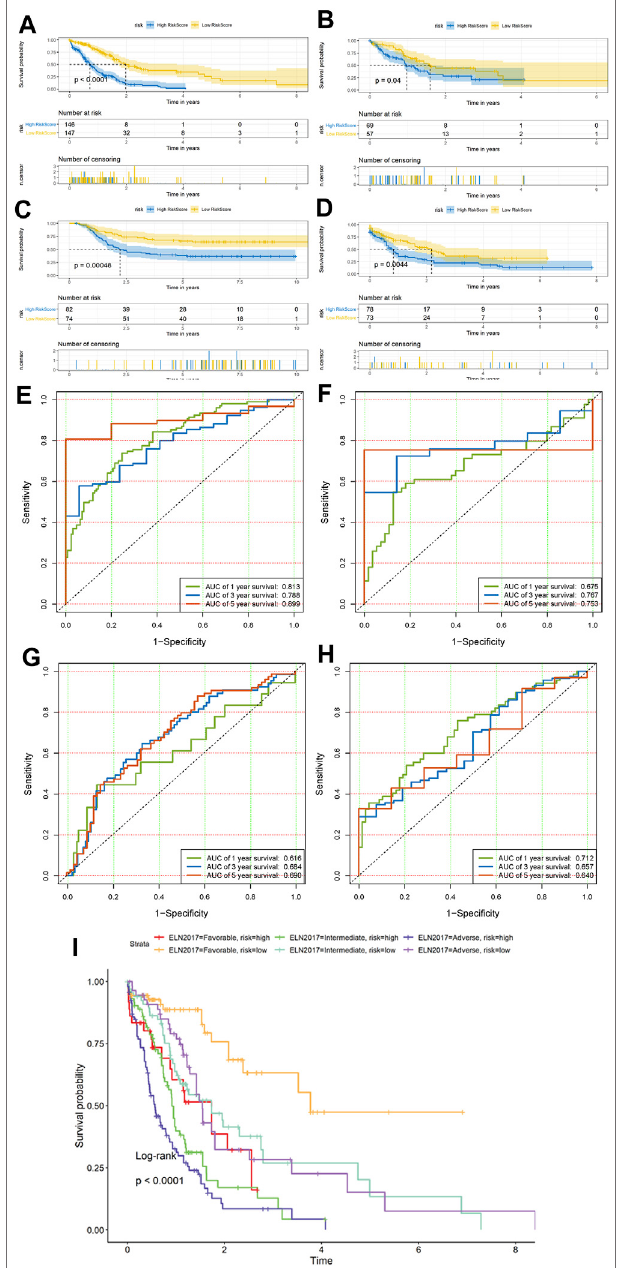
FIGURE 3 | Prognostic value of the hypoxia risk score Kaplan – Meier survival curves of overall survival (OS) between the low- and high-risk group patients in all three cohorts. (A) Training dataset of Cohort 1 and (B) test dataset of Cohort 1, (C) Cohort 2, and (D) Cohort 3. ROC curves of the hypoxia risk score model based on the 18 characteristic genes. (E) Training dataset of Cohort 1 and (F) test dataset of Cohort 1, (G) Cohort 2, and (H) Cohort 3. ROC, receiver operating characteristic; AUC, area under the curve. (I) Comparison of survival between six different ELN2017 and hypoxia-related prognosis model (HPM) risk subgroups of